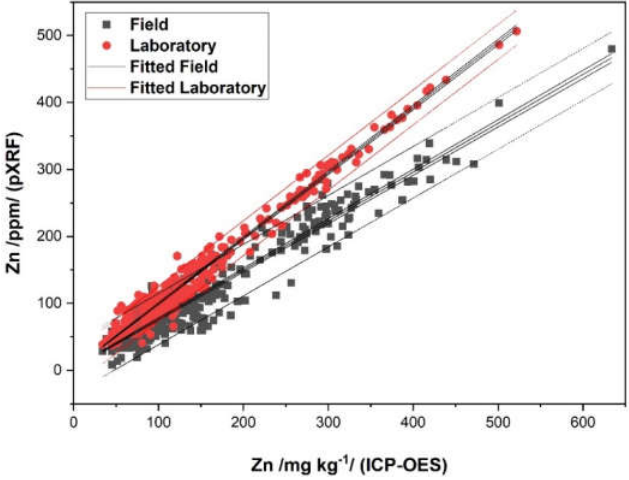
Figure 6. Statistical significance of regression model for Zinc (pXRF) in soil samples from experimental soil sites from Otava and Mže river basins measured in FIELD and LABORATORY.